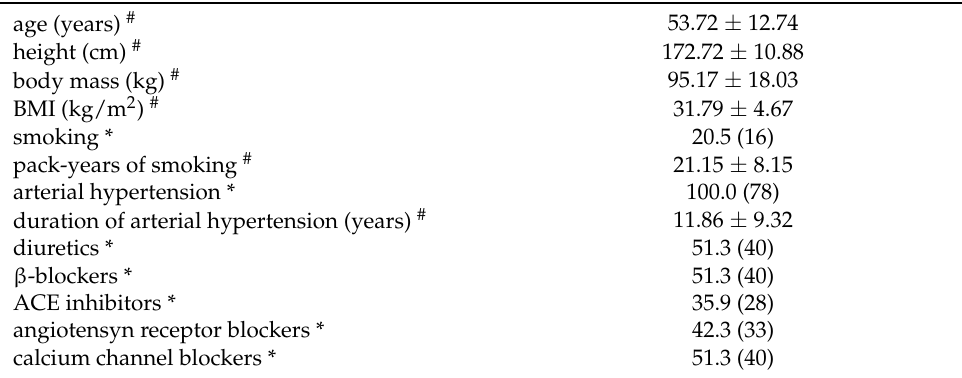
Table 1. Clinical characteristics of the study